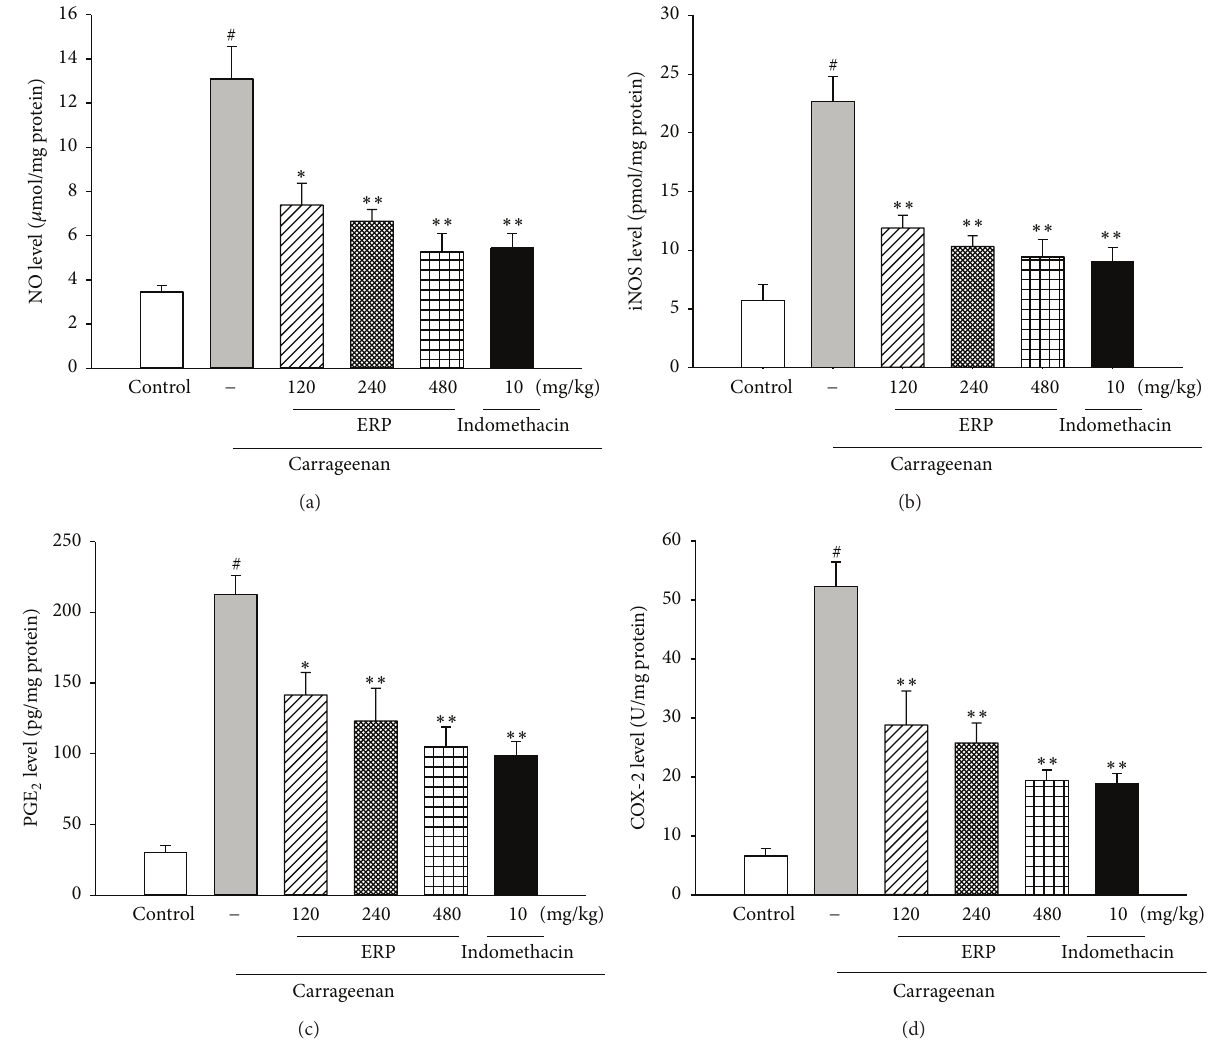
Figure 4: Effect of ERP on carrageenan-induced the level of NO, iNOS, PGE 2 and COX-2 in mouse paw edema. (a) NO. (b) iNOS. (c) PGE 2 . (d) COX-2. Data represented the mean ± S.E.M. ( 𝑛 = 10 ). # 𝑃 < 0.01 compared to the control group; ∗ 𝑃 < 0.05 and ∗∗ 𝑃 < 0.01 compared to the carrageenan-control